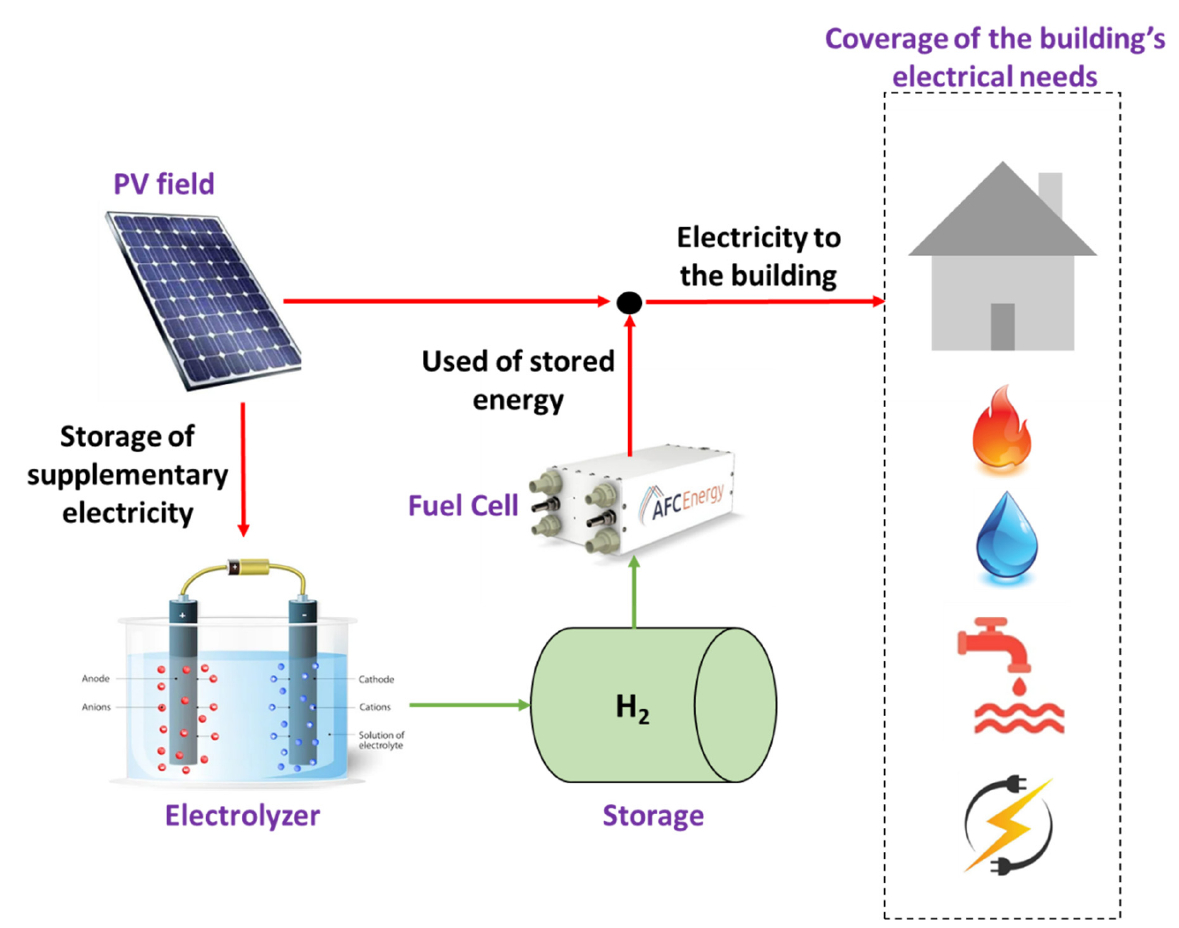
Figure 2. The suggested system for covering all the energy needs of the building.